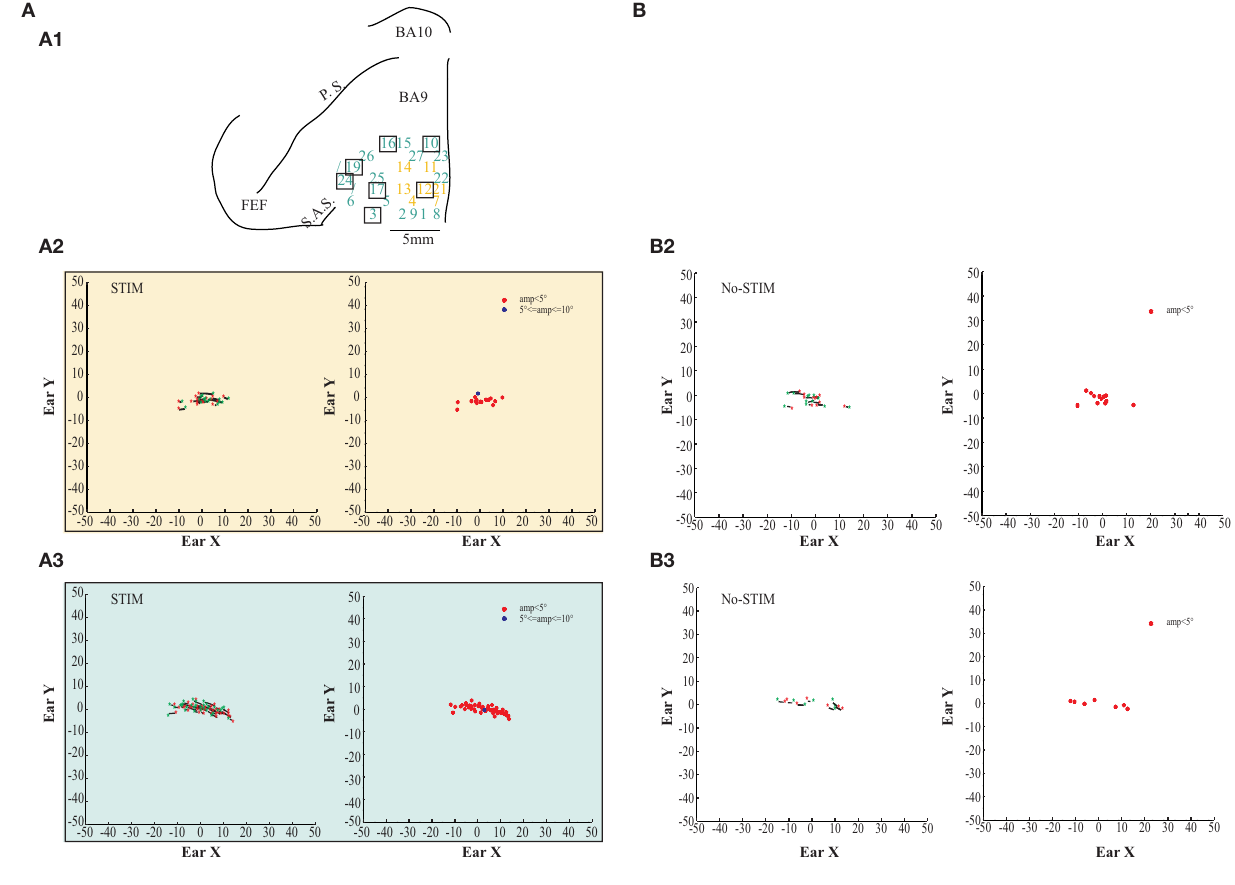
informative as the analysis of the eye movements. This is because the eyes have a high motility in all directions (up-down-right- left), while the ears have a high motility principally in only